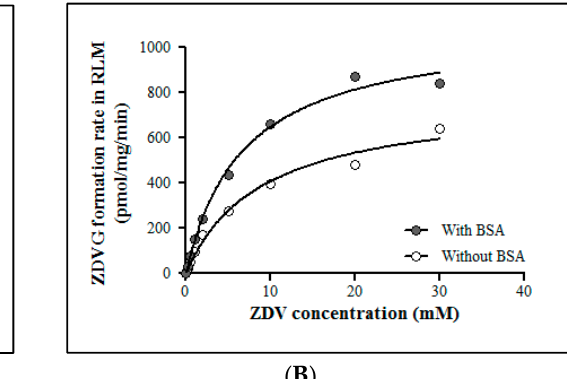
Table 4. Derived kinetic constants for zidovudine glucuronidation in human (HLM) and rat liver microsomes (RLM) obtained from the incubation with and without 1% ( w / v ) bovine serum albumin (BSA). Data are presented as mean ± SD.